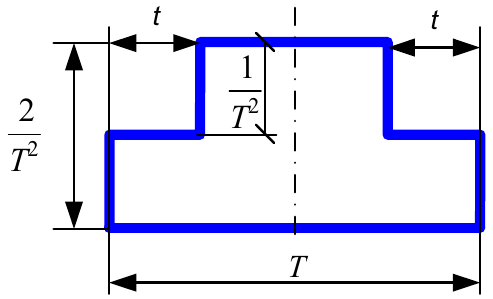
Figure 5: Graph of the PDF of travel time for a random trip in a one-dimensional zone.